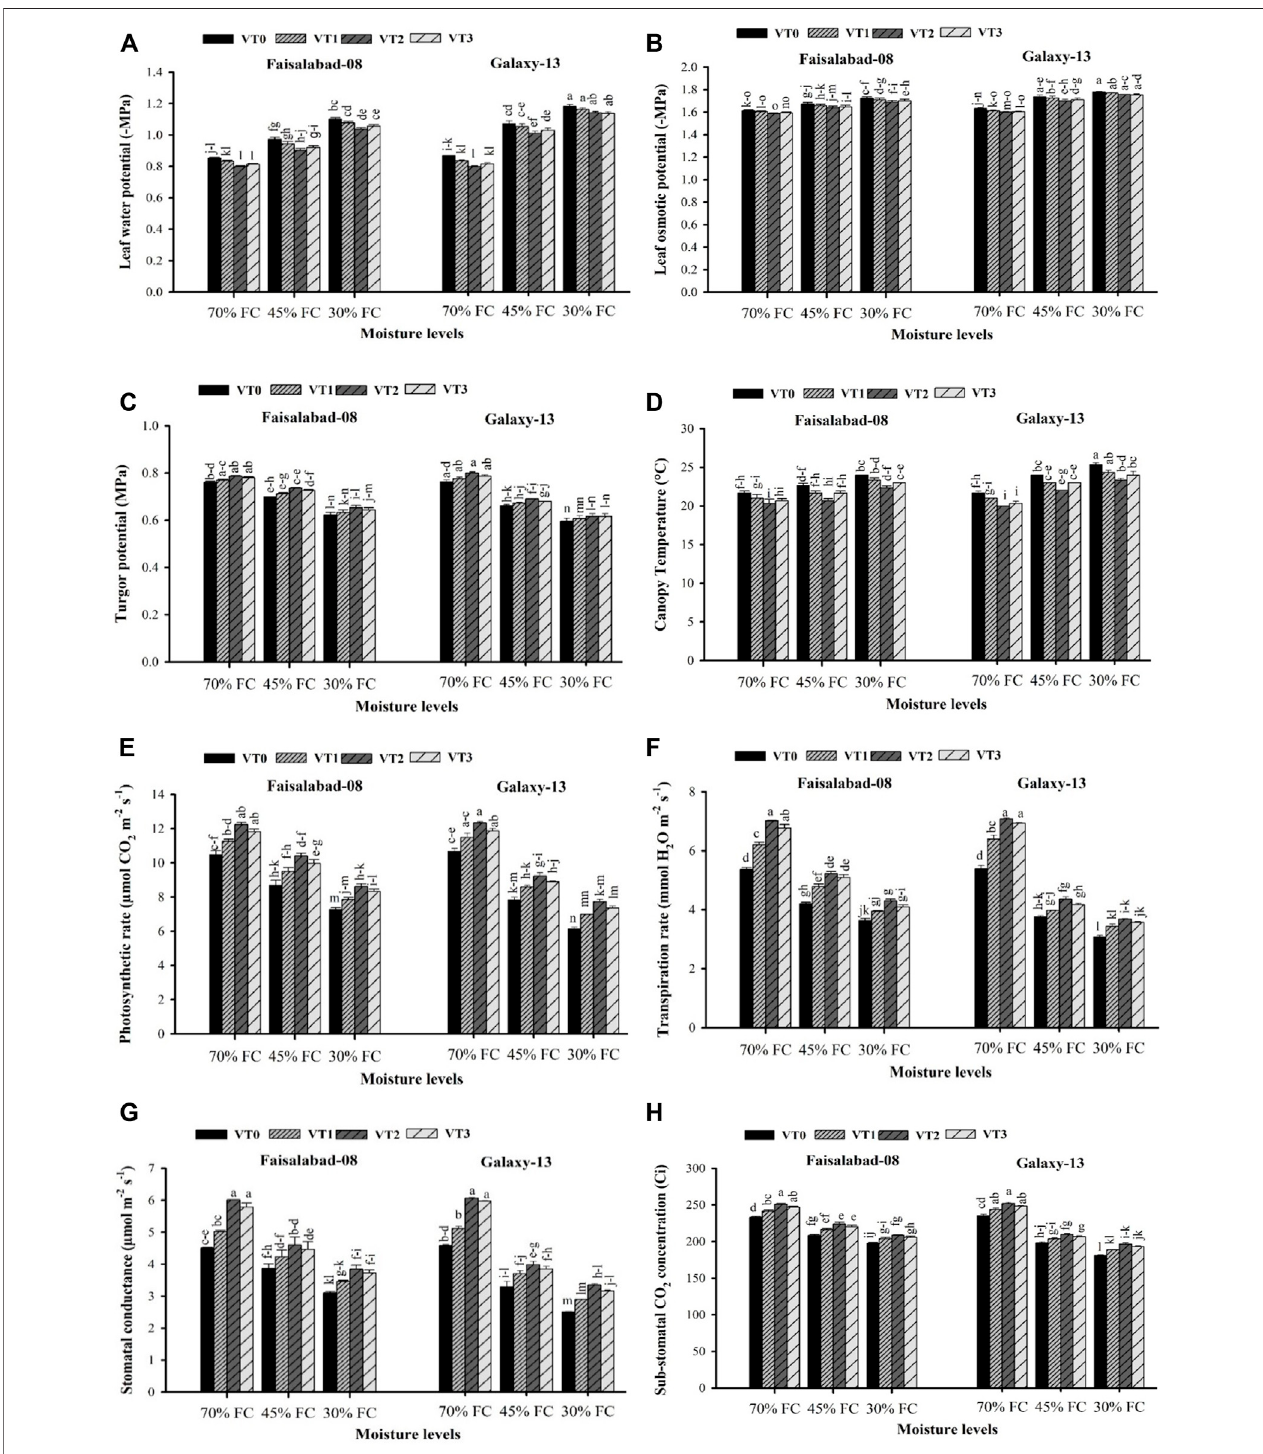
FIGURE 4 | Effect of soil-applied cellulolytic microbe-enriched rice straw vermicompost on leaf water potential (A) , leaf osmotic potential (B) , turgor potential (C) , canopy temperature (D) , photosynthetic rate (E) , transpiration rate (F) , stomatal conductance (G) , and sub-stomatal CO 2 concentration (H) of the two wheat cultivars Faislabad-08 and Galaxy-13 under different drought levels: well-watered condition (70% fi eld capacity-FC), moderate drought (45% FC), and severe drought (30% FC). Bars with different small letters show signi fi cant differences at a 5% probability level according to Tukey ’ s HSD test.